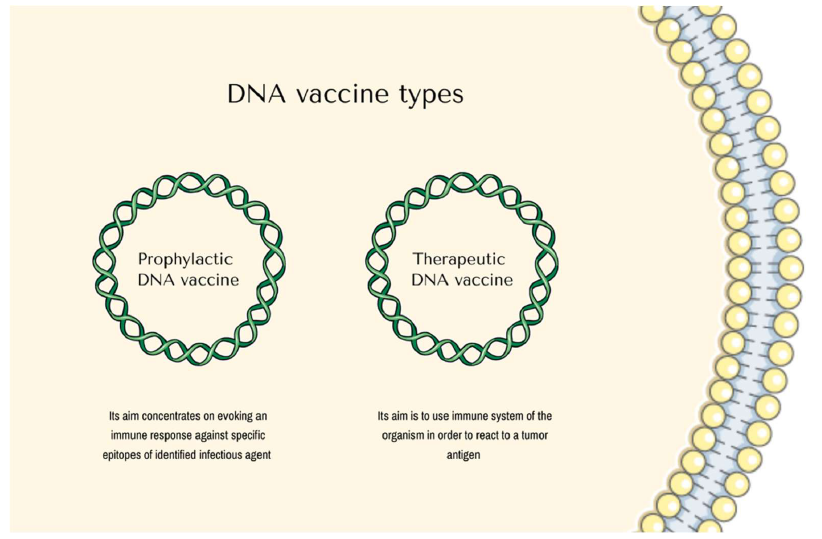
Figure 3. Schematic visualization of the chain of events that arises while deploying intratumoral ECT and peritumoral immunogen electrotransfer [63]. The Figure was partly generated using Servier Med- ical Art, provided by Servier, licensed under a Creative Commons Attribution 3.0 unported